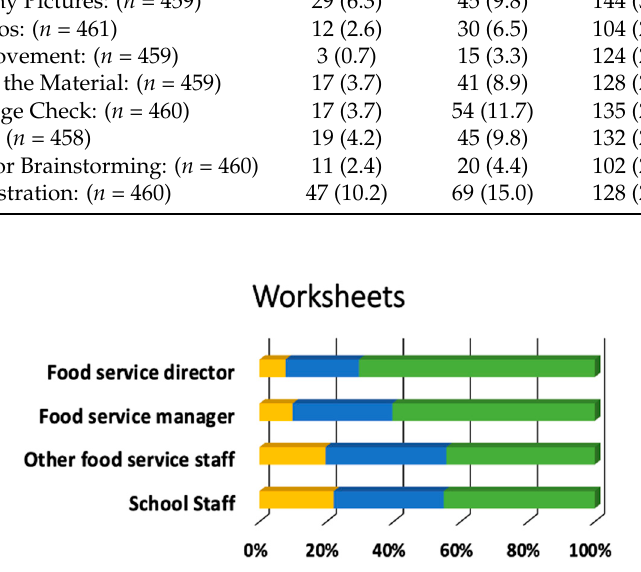
Figure 1. Preference for completing worksheets significantly differed by participant role. [ n = 458 (food service director, n = 155; food service manager, n = 111; other food service staff, n = 61; school staff, n = 131), χ 2 (6) = 27.7, p < 0.001, Cramer’s V = 0.17].